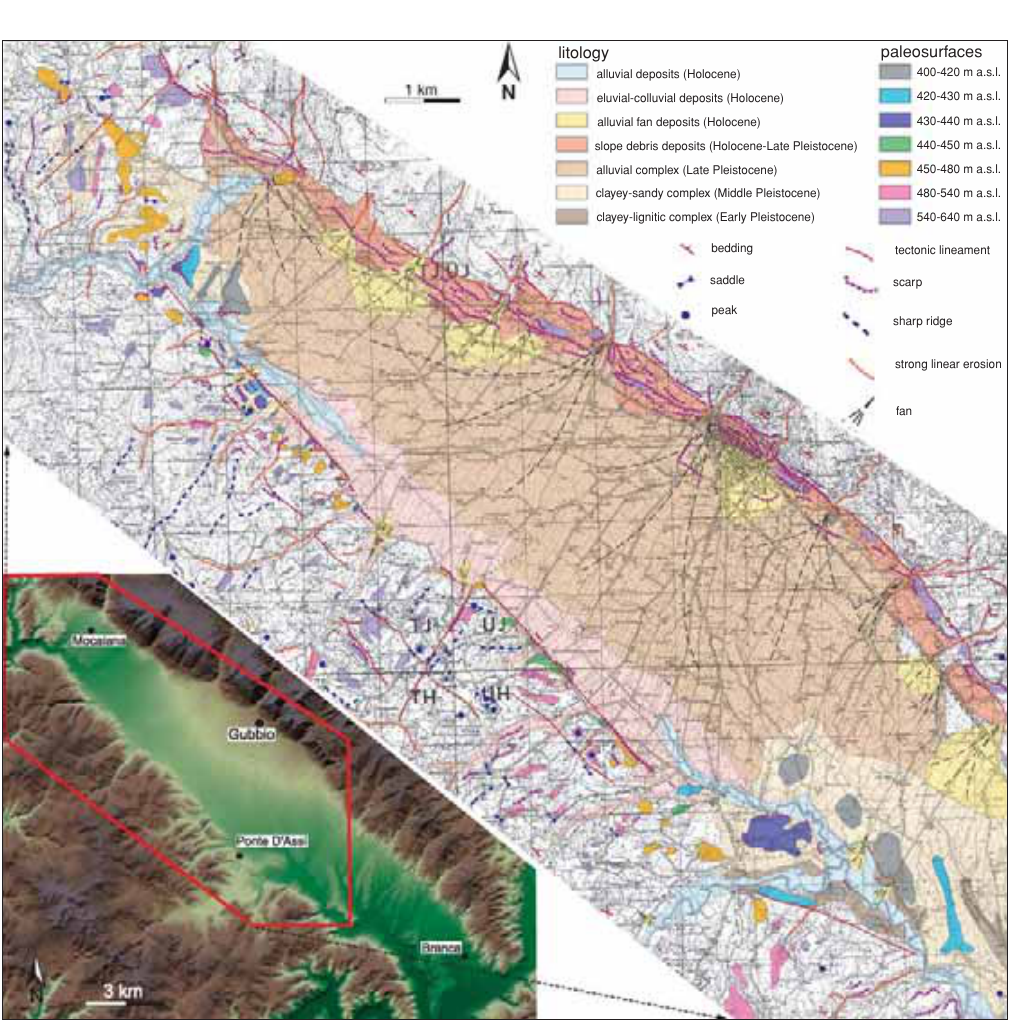
Fig. 6. Map of Quaternary geology and geomorphology of the northern and central portion of the Gubbio Basin from aerial photo and field survey. The lower left inset shows the location of the study area (see also dashed area in fig. 2) on the 5-m resolution